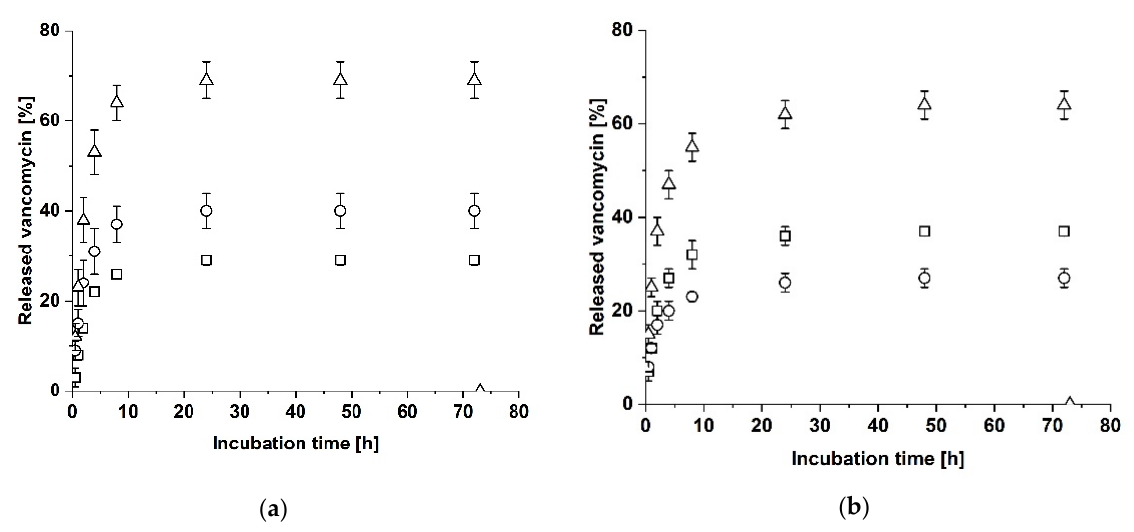
Figure 4. Release of vancomycin from a two-layer laminate consisting of Atelocollagen and Collagen Solutions. Atelocollagen was loaded with vancomycin and the release in the upper cavity (squares), the lower cavity (dots) and in total (triangles) was analyzed. After 72 h, the collagen sheet was incubated for an additional hour in PBS without the sample holder. The error bars represent the standard deviation ( n = 3). ( a ) Atelocollagen facing the upper cavity. ( b ) Atelocollagen facing the lower cavity.